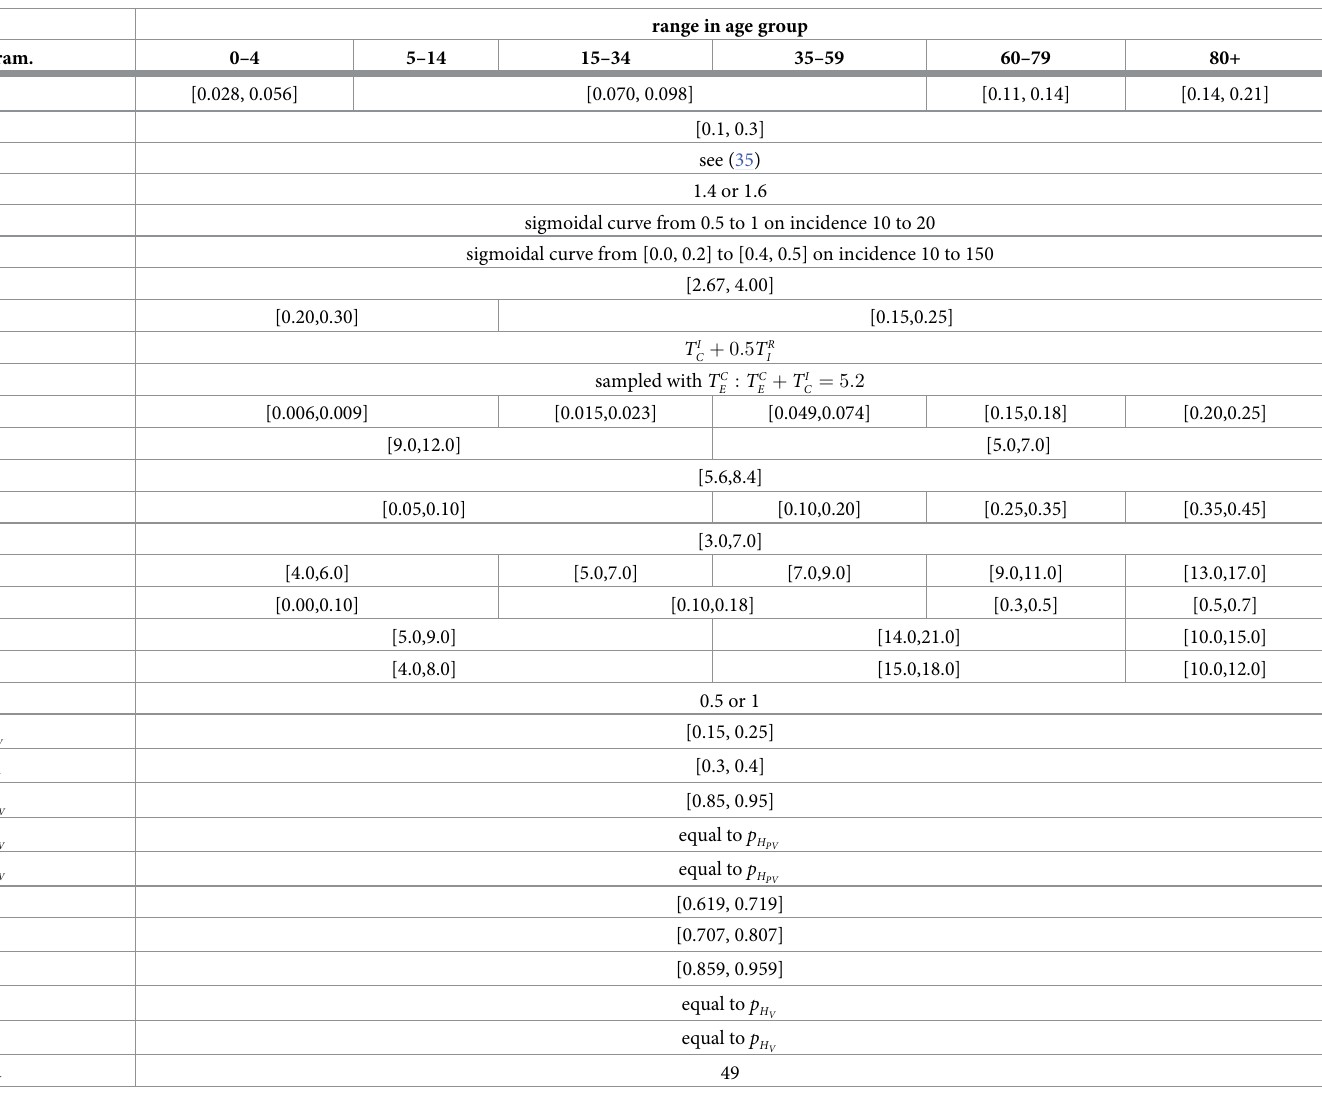
Table 1. Parameter list for the local SIR-type model. Parameter list for the local SIR-type model as presented in Fig 1. For details on parameter estimations of the base model, see [6].